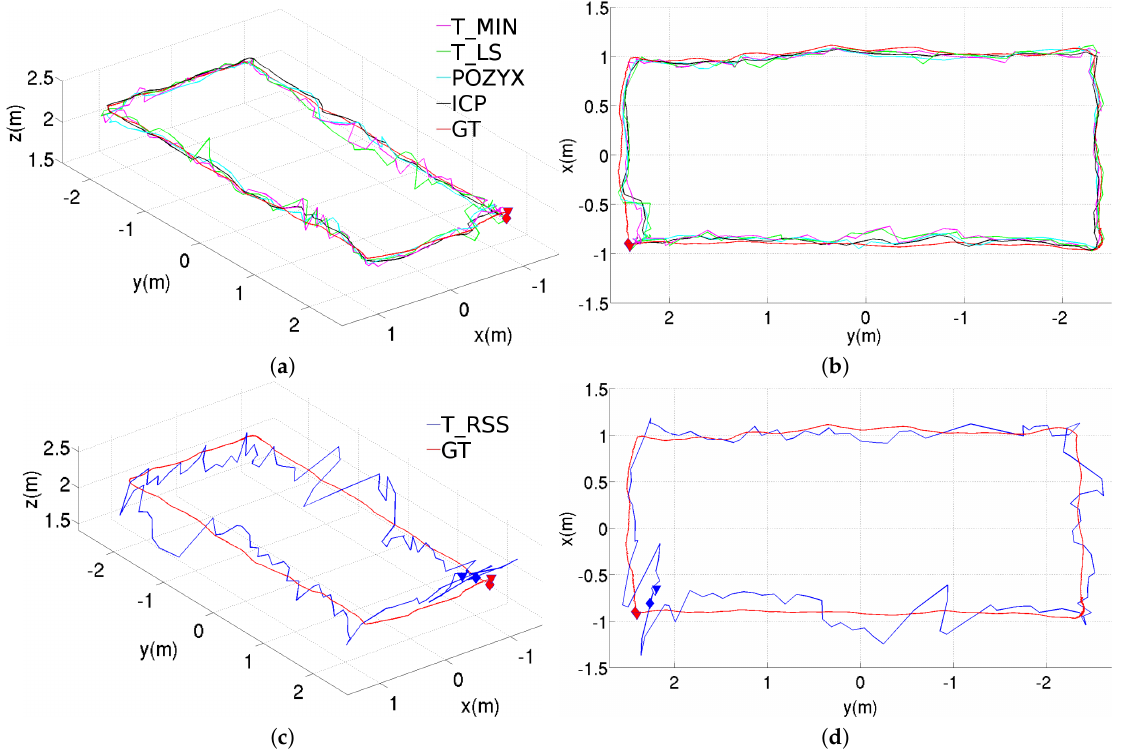
Figure 5. Position estimations provided by the different methods for the rectangular trajectory using the standalone configuration, results for the T_RSS method are shown separately to facilitate the comparison: ( a ) perspective and ( b ) top views for T_MIN, T_LS, POZYX and ICP, ( c ) perspective and ( d ) top views for